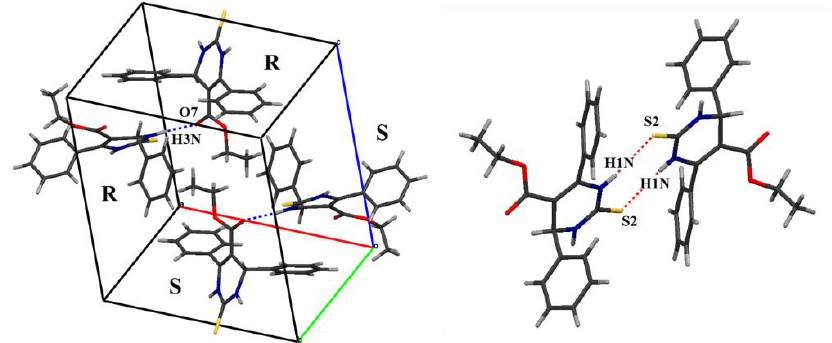
Figure 4. Hydrogen bonds in compound 4a : Inside the unit cell (left) and with other molecules outside the unit cell (right).